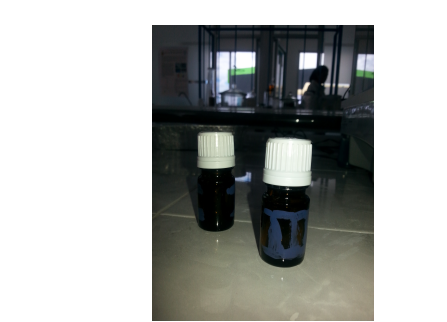
Figure A2. Material cover.